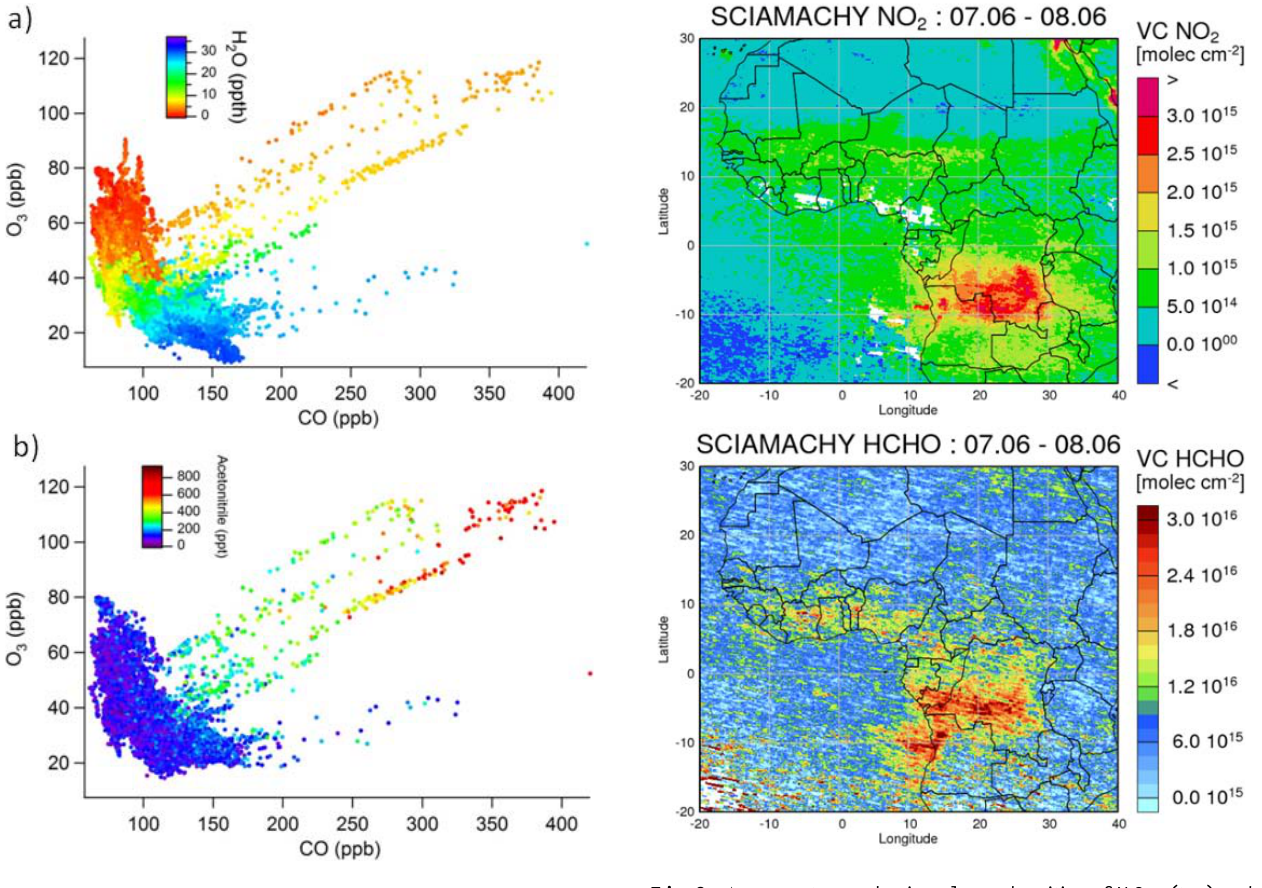
Fig. 7. Ozone and CO correlations coloured by a) water vapour and b) acetonitrile. Data from the BAe-146 only.